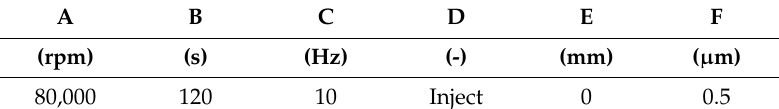
Table 6. Optimization results for machining the AISI 304 micro-diameter.